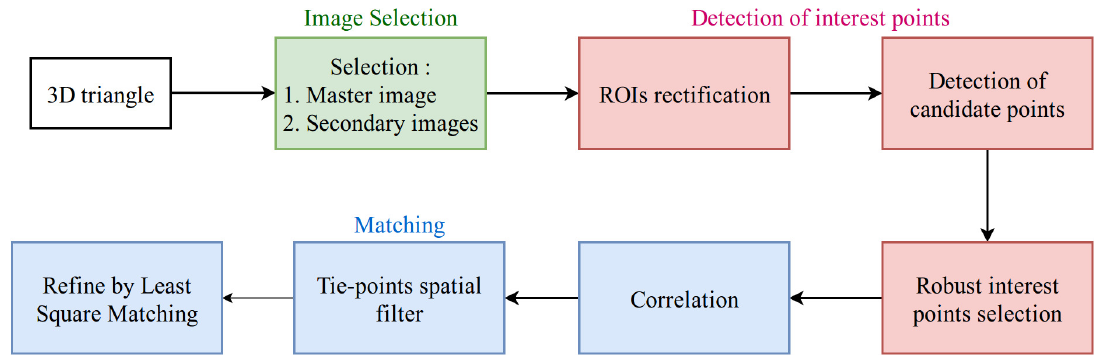
Figure 2. Three general steps of the tie-point extraction method: Image selection, Detection of interest points and Matching.